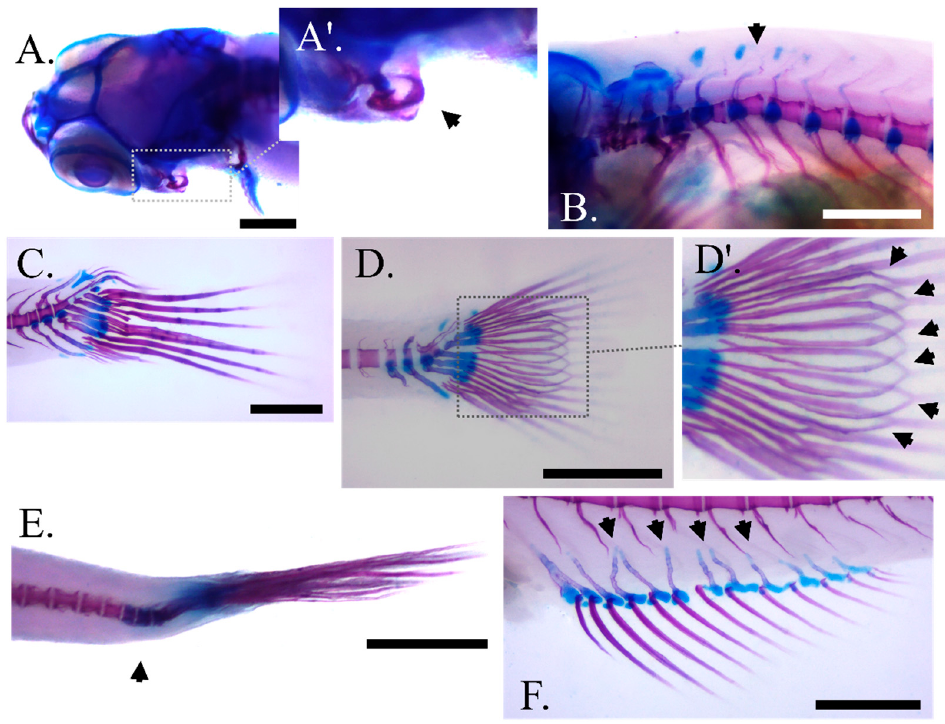
Figure 4. Main skeletal abnormality types observed at the end of larval rearing in zebrafish fed with the experimental diets (C, P6, P12) according to the two feeding regimes (DF, ADF). ( A , A ′ ) Angled view of the abnormal gill cover with magnification on the malformed bone, respectively. ( B ) Pre- haemal kyphosis. ( C ) Missing and compressed caudal fin rays in DF regime. ( D , D ′ ) Unbundling of the caudal fin lepidotrichia in ADF regime with magnification on the malformed bones respectively (black arrows). ( E ) Scoliosis of the caudal peduncle. ( F ) Disorientated anal fin pterygiophores (black arrows). Scale bar equals 0.5 mm.